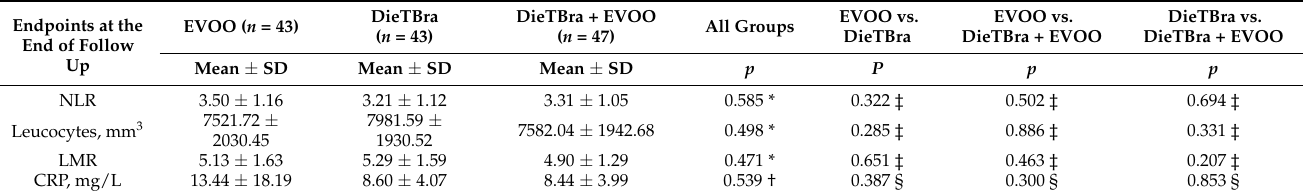
Table 3. Multiple comparisons of the mean values at the end of follow up in all intervention groups in individuals with severe obesity.